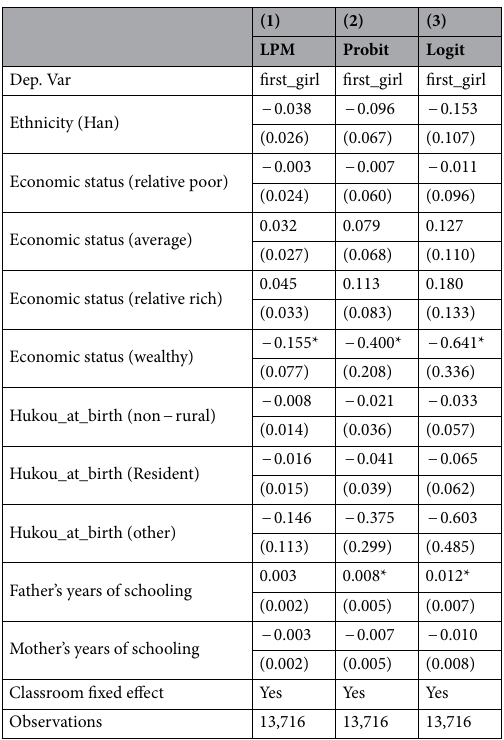
Table 6. Regression of firstborn girl on household characteristics. Notes: Robust standard errors, clustered by classroom, are shown in parentheses. LPM is linear probability